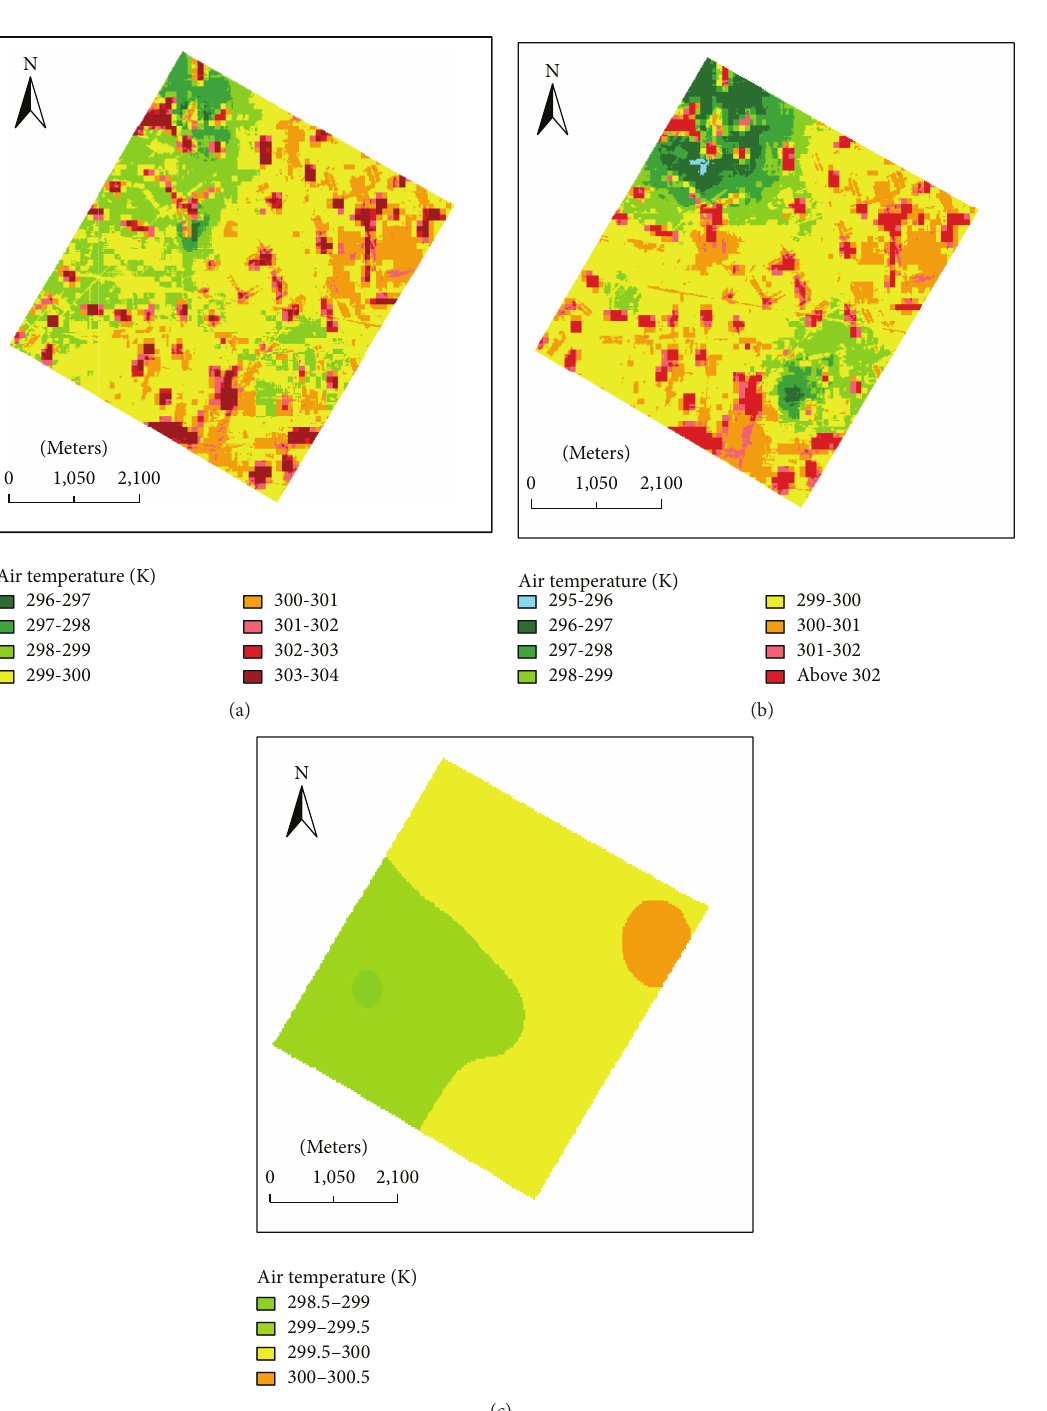
Figure 4: Air temperature retrieved by the IADEBAT model (a), the ADEBAT model (b), and the IDW method (c) on July 10th, 2012.